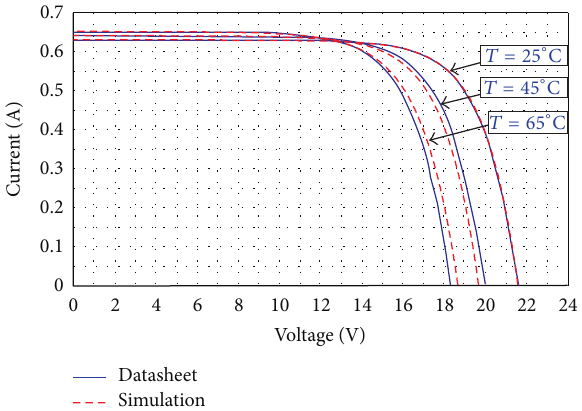
Figure 5: 𝐼 × 𝑉 curve for different values of temperature.